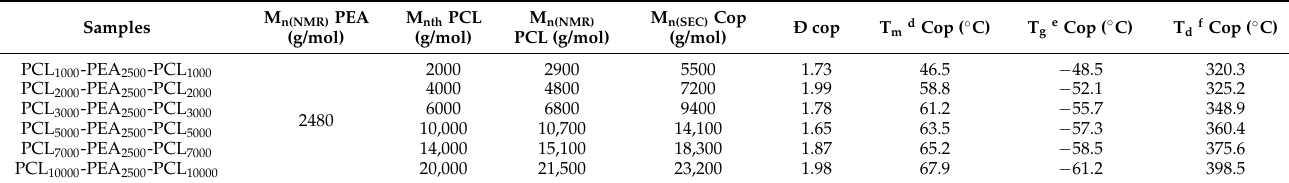
Table 3. Molecular characteristics of PCL-b-PEA-b-PCL copolymers.